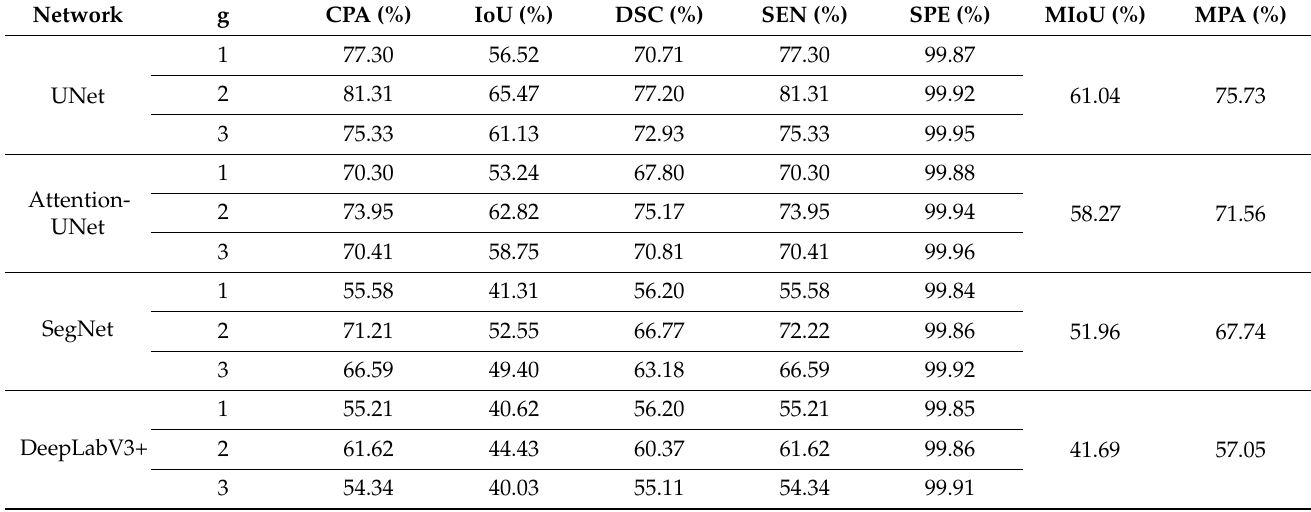
Table 3. Detailed performance using refined hierarchical labels.